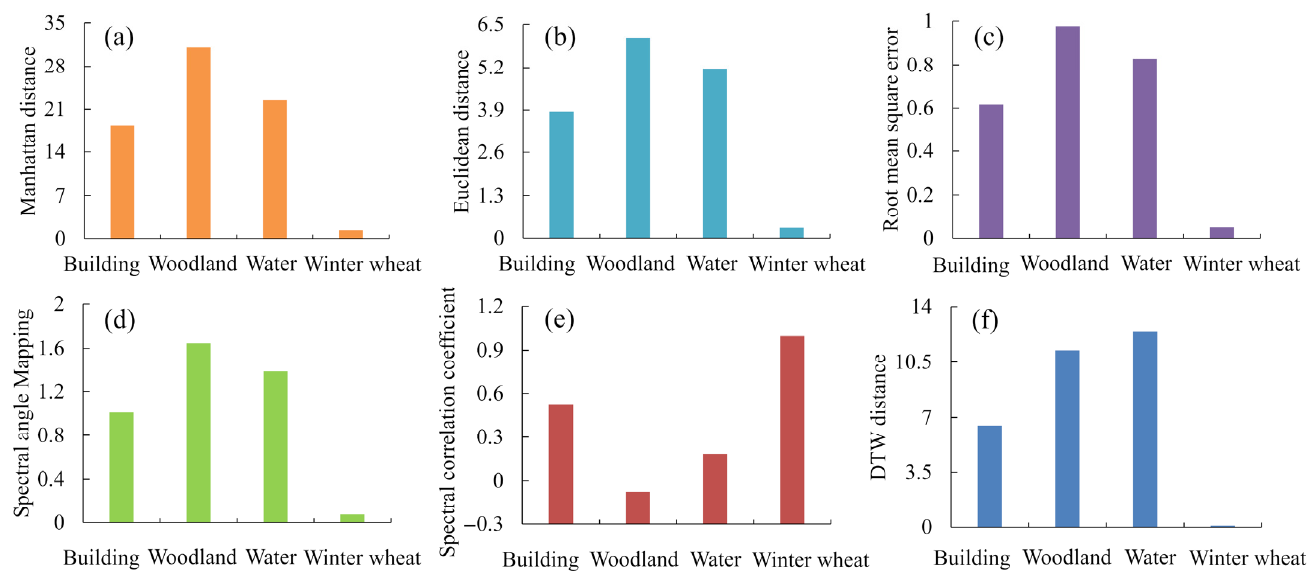
Figure 6. Average similarity of each land cover type with different indicators: ( a ) MD, ( b ) ED, ( c ) RMSE, ( d ) SAM, ( e ) SCC, ( f ) DTW.